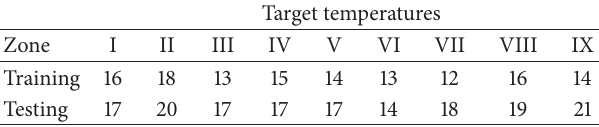
Table 2: Training and testing zones’ target temperature.